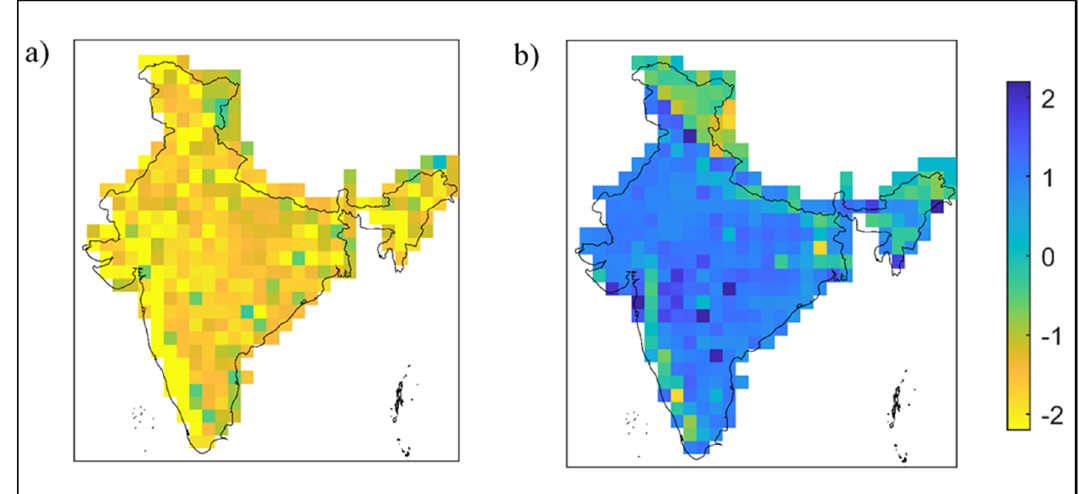
Figure 6. Spatial distribution of ( a ) Cold and Wet Spell (CWS) and ( b ) Hot Nights and Wet Days (HNWD) across India during the future period i.e., 2075–2084. The figure was produced using MATLAB software (version R2021a, URL: https:// in. mathw orks. com).